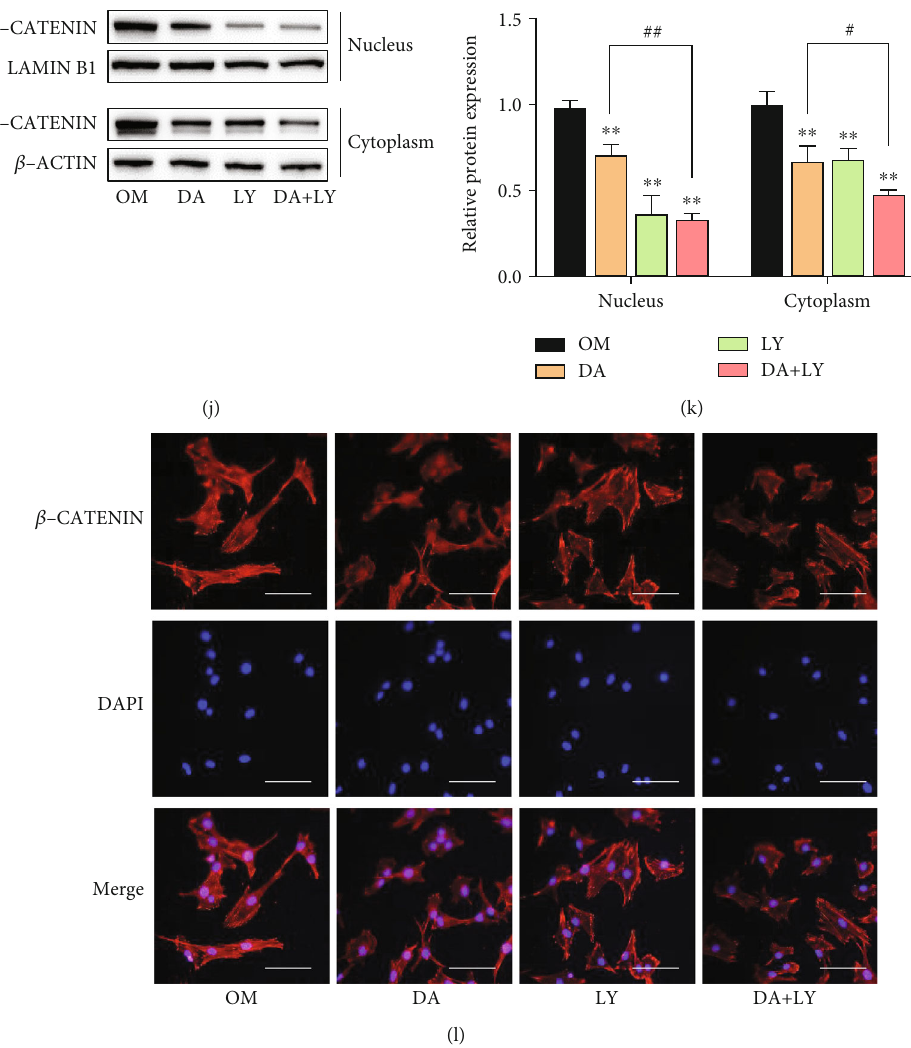
Figure 6: LY294002 exacerbates the attenuation of DA on rBMSC osteogenic di ff erentiation via the AKT/GSK-3 β / β -catenin pathway. rBMSCs were pretreated with 5 μ M LY294002 for 2h and then cultured in osteogenic medium containing 10 -5 M DA. (a) ALP staining of rBMSCs after 7 days of di ff erentiation. Optical photos (upper photo) and microscopic images (lower photo). (b) ALP activity of rBMSCs measured after 7 days of di ff erentiation. (c) Calcium nodules assessed by Alizarin Red staining after 14 days of di ff erentiation. Optical photos (upper photo) and microscopic images (lower photo). (d) Relative quanti fi cation of Alizarin Red staining. (e) Expressions of Col1a1 , Alp , Runx2 , Opn , and Ocn measured by qRT-PCR assay after 7 days of di ff erentiation. (f, g) Expression of COL1A1, ALP, RUNX2, OPN, and OCN measured by western blot assay after 7 days of di ff erentiation. (h) Expression of GSK-3 β and p-GSK-3 β measured by western blot assay after 24 h of di ff erentiation. (i) Quanti fi cation of p-GSK-3 β /GSK-3 β ratio. (j, k) The expression levels of nuclear and cytoplasmic β -CATENIN analyzed by western blot. (j) and quanti fi ed (k) in the indicated groups after 24 h of di ff erentiation. (l) The translocation of β -CATENIN in the nucleus assessed by immuno fl uorescence assay after 24 h of di ff erentiation. β - CATENIN was stained as red, and nuclei were stained by DAPI showing blue. Scale bar, 100 μ m. ∗ p < 0 : 05 and ∗∗ p < 0 : 01 compared to OM group; # p < 0 : 05 and ## p < 0 : 01 compared to DA group; ns: no signi fi